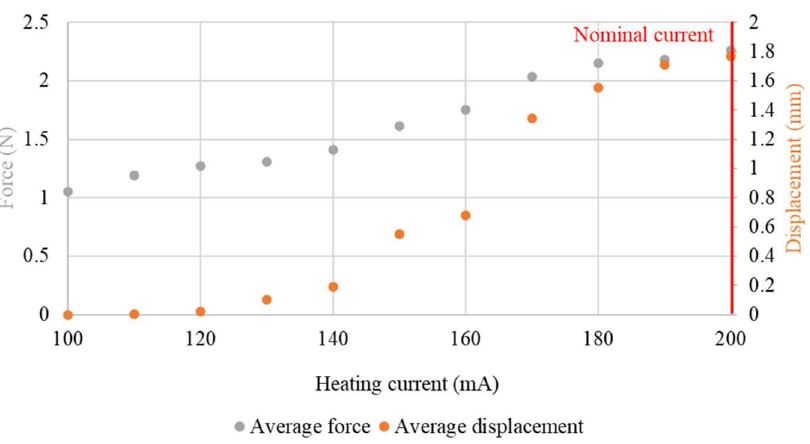
Figure 12. Relationship of average force and average displacement with heating current (test sample diameter, 100 μm).